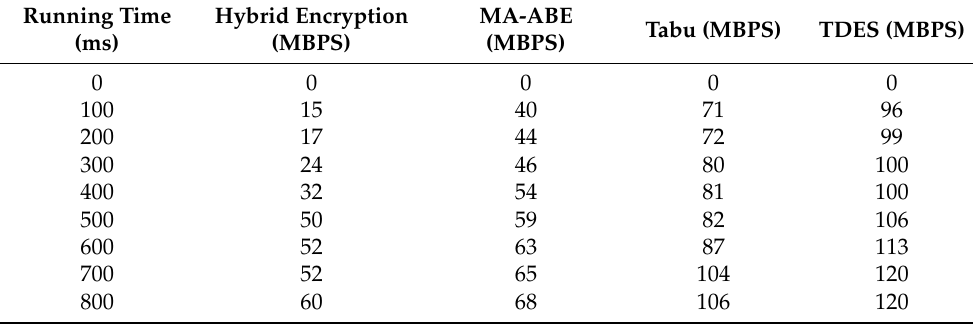
Table 11. Throughput of TDES in comparison with existing